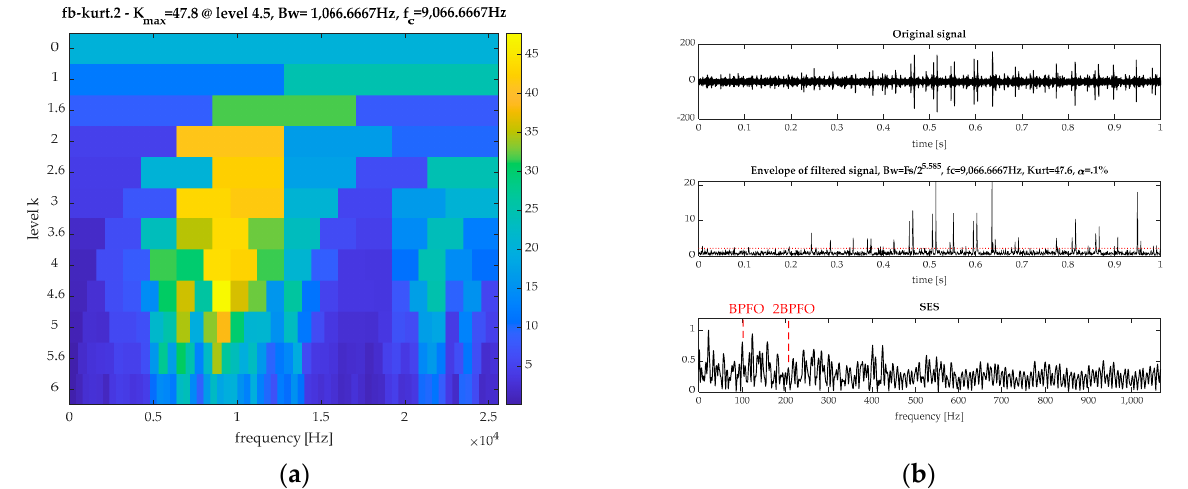
Figure 11. The results by FK for the outer fault signal: ( a ) spectrum kurtosis and ( b ) the filtered signal and its SES.